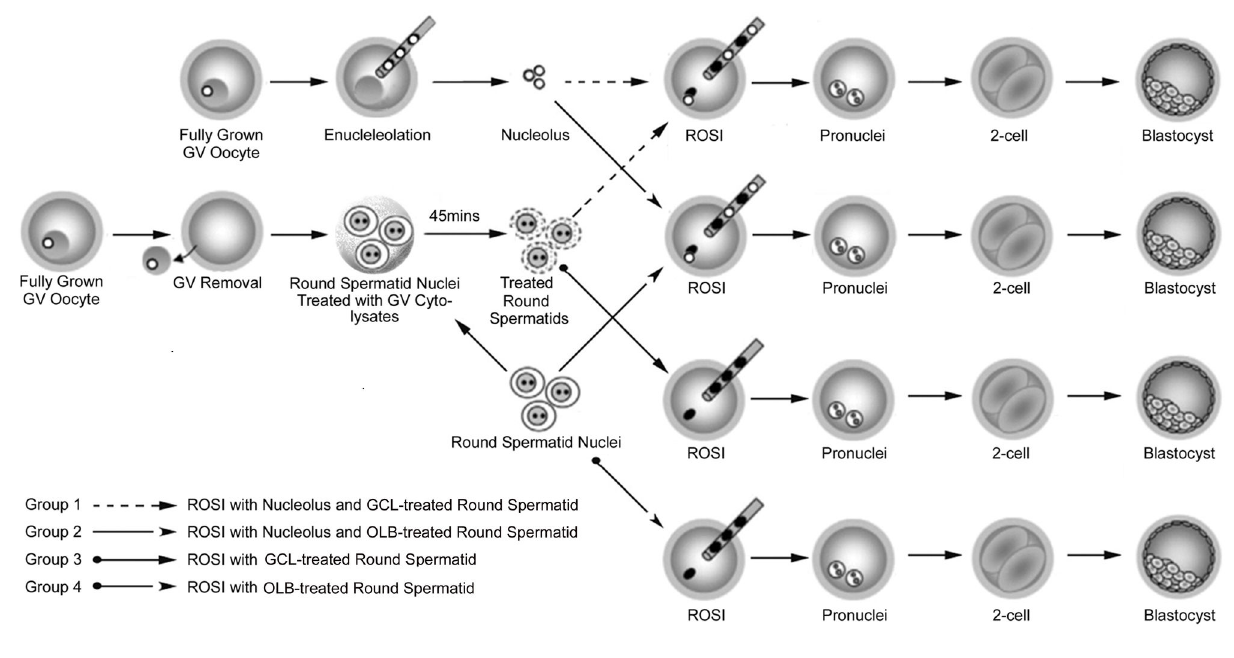
Figure 1. Overview of the experimental design. This study consisted of four experimental groups and one ICSI control group. In Group 1, a round spermatid treated with GV cytolysates and a nucleolus were both injected into an MII oocyte; in Group 2, a oocyte lysis buffer treated-round spermatid and a nucleolus were injected into an MII oocyte; in Group 3, only a round spermatid treated with GV cytolysates was injected into an MII oocyte; and in Group 4, only oocyte lysis buffer treated-round spermatids were injected into an MII oocyte. GCL; GV cytolysate. OLB; Oocyte lysis